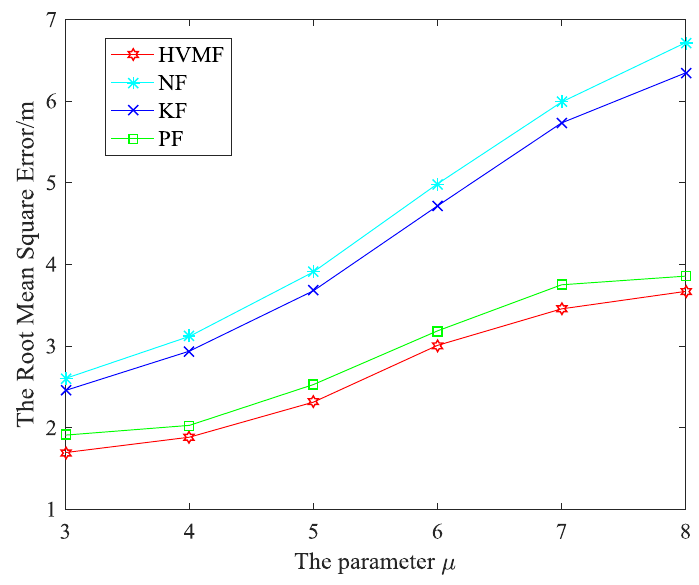
Figure 19. The parameter µ versus RMSE.